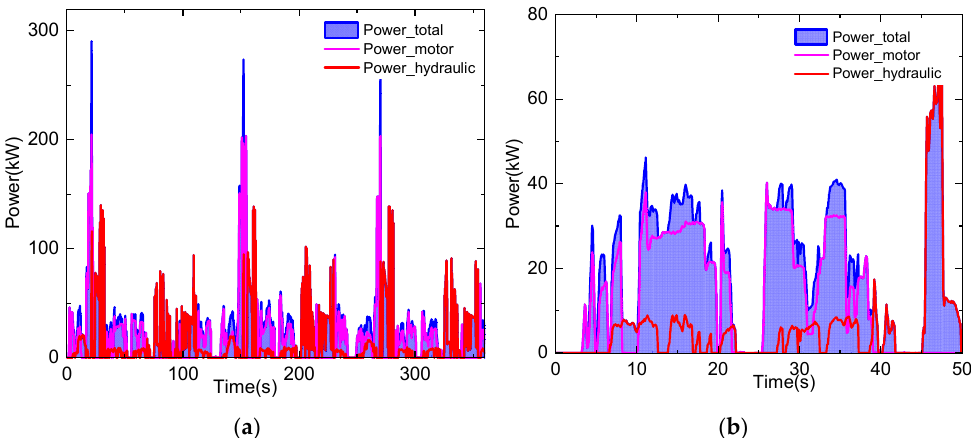
Figure 12. Power distribution of typical working cycle: ( a ) global distribution; ( b ) power distribution in running condition.